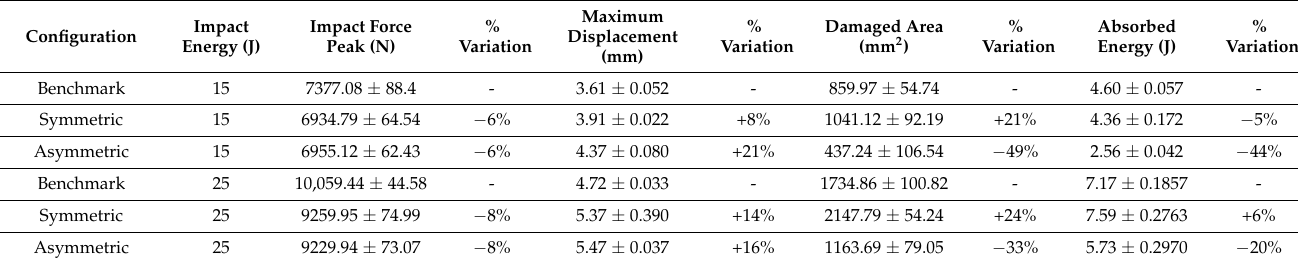
Figure 12. Bar plot with the mean and standard deviation of the ( a ) impact force peak, ( b ) maximum displacement, ( c ) damaged area and ( d ) absorbed energy for the benchmark, symmetric (FGPS) and asymmetric (FGPA) configurations. Table 3. Mean and standard deviation of the impact results for the benchmark, symmetric (FGPS) and asymmetric (FGPA) configurations.